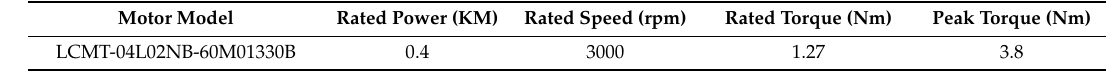
Table 2. The main parameters of the speed reducer.